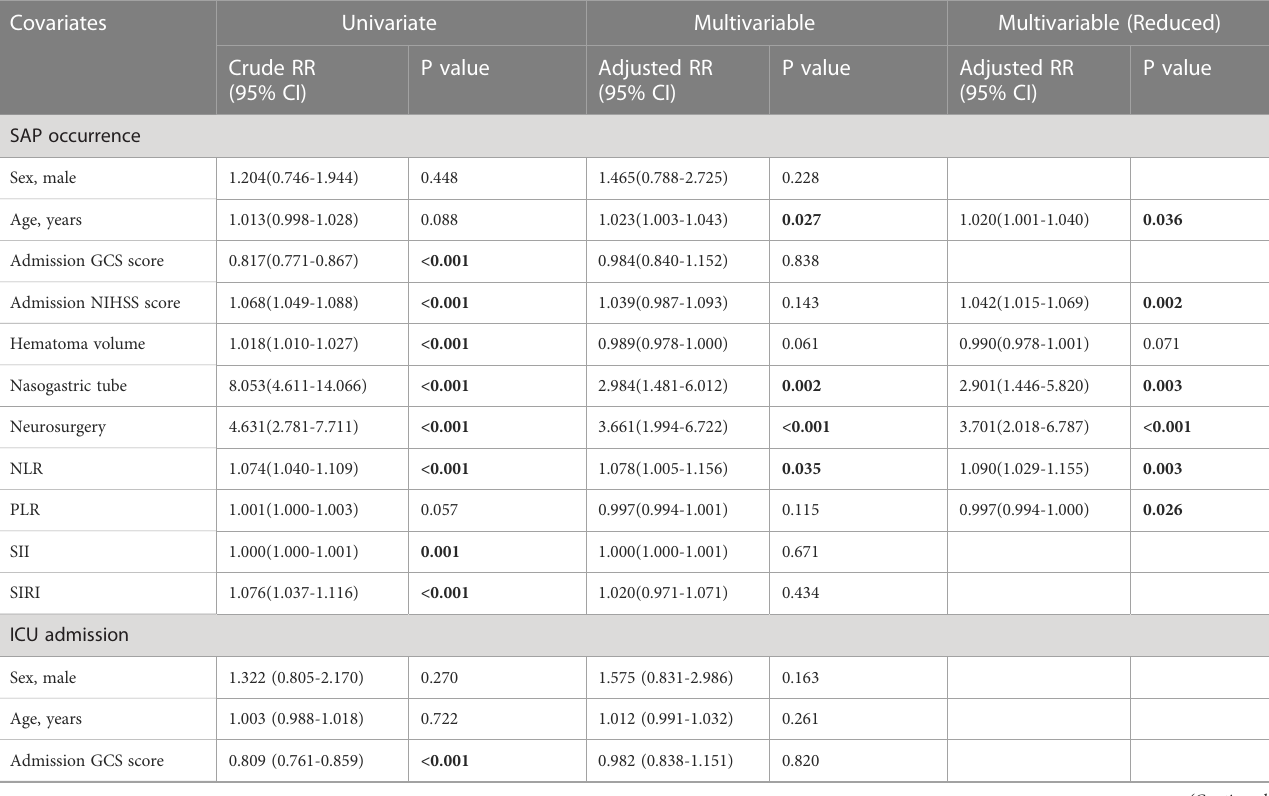
TABLE 3 Logistic regression models for SAP occurrence and ICU